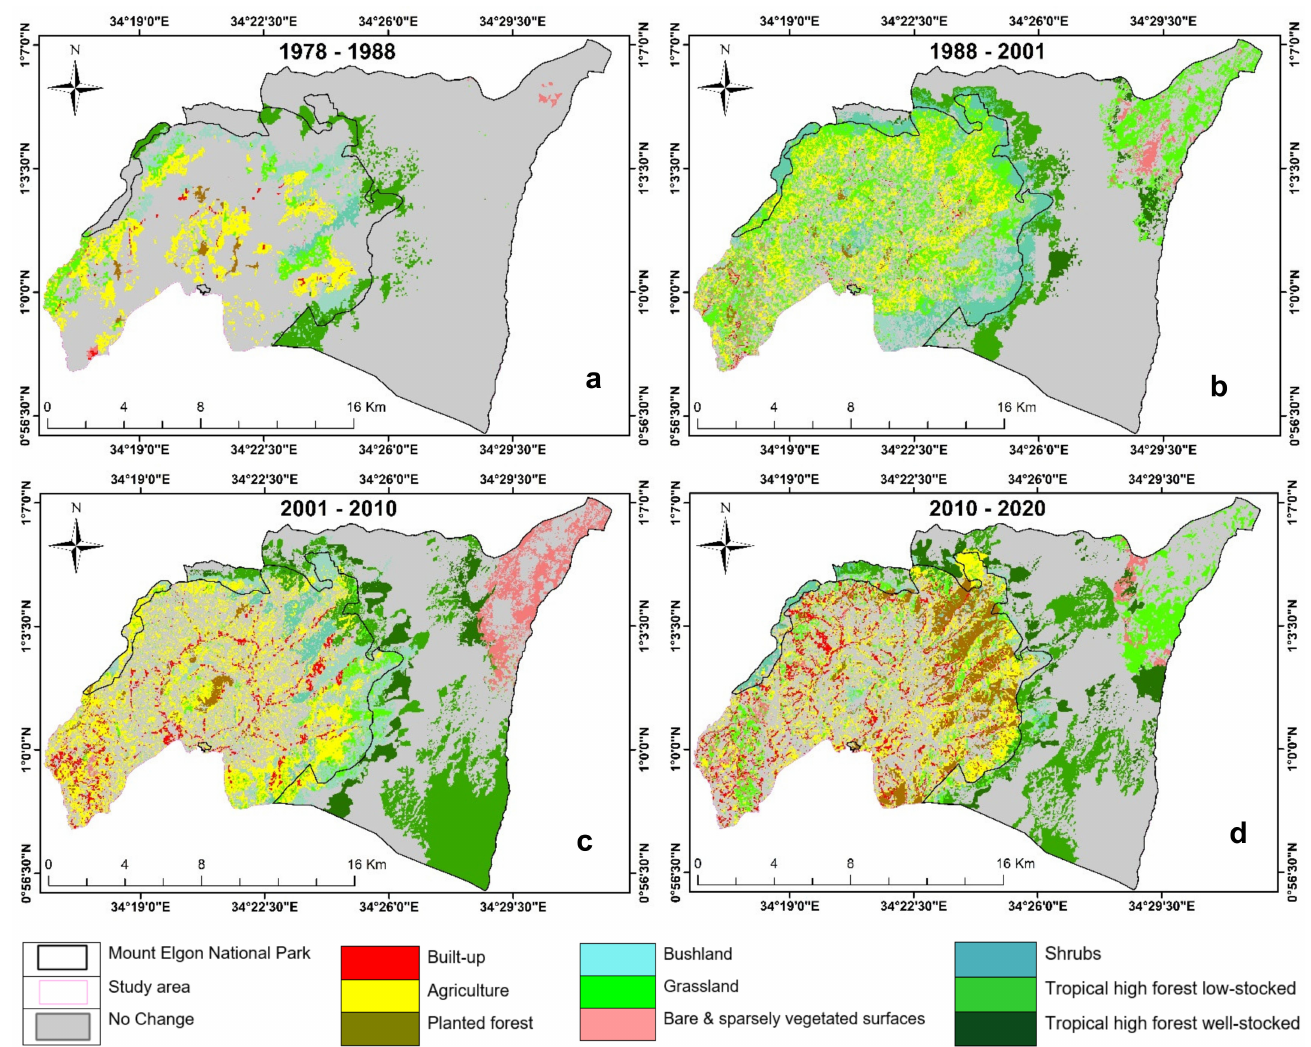
Figure 8. The geospatial distribution of land cover change flows for ( a ) 1978–1988, ( b ) 1988–2001, ( c ) 2001–2010, and ( d ) 2010–2020. The colors represent the “into” (final) land cover gains by each class at end year (1988, 2001, 2010, and 2020). The grey color represents the persistent land cover area (that did not change) in the years 1978, 1988, 2001, 2010, and